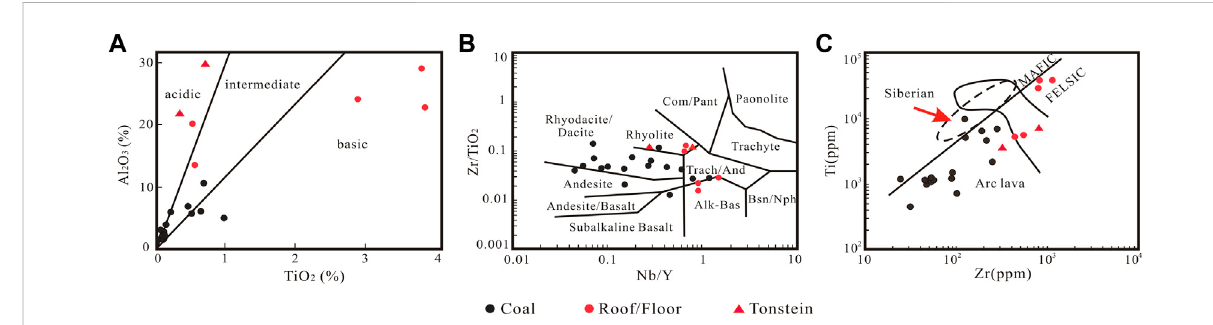
FIGURE 7 (A) Zr versus Ti diagram (modi fi ed from He et al., 2014), (B) plots of mass fractions of Al 2 O 3 versus TiO 2 , and (C) Zr/TiO 2 versus Nb/Y diagram (modi fi ed from He et al.,